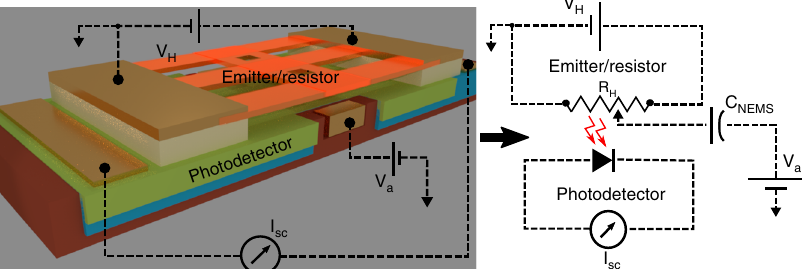
Fig. 5 Heat transfer measurement setup. External circuit connections for the heat transfer measurements shown in Fig. 4 along with the equivalent electrical circuit of the device and the measurement setup. The emitter is applied a potential V H to heat up, and the detector current ( I sc ) is measured for different NEMS actuation potentials ( V a ). In the equivalent circuit, the NEMS actuator is represented by capacitor C NEMS , the emitter as electrical resistor R H and, the photodetector as